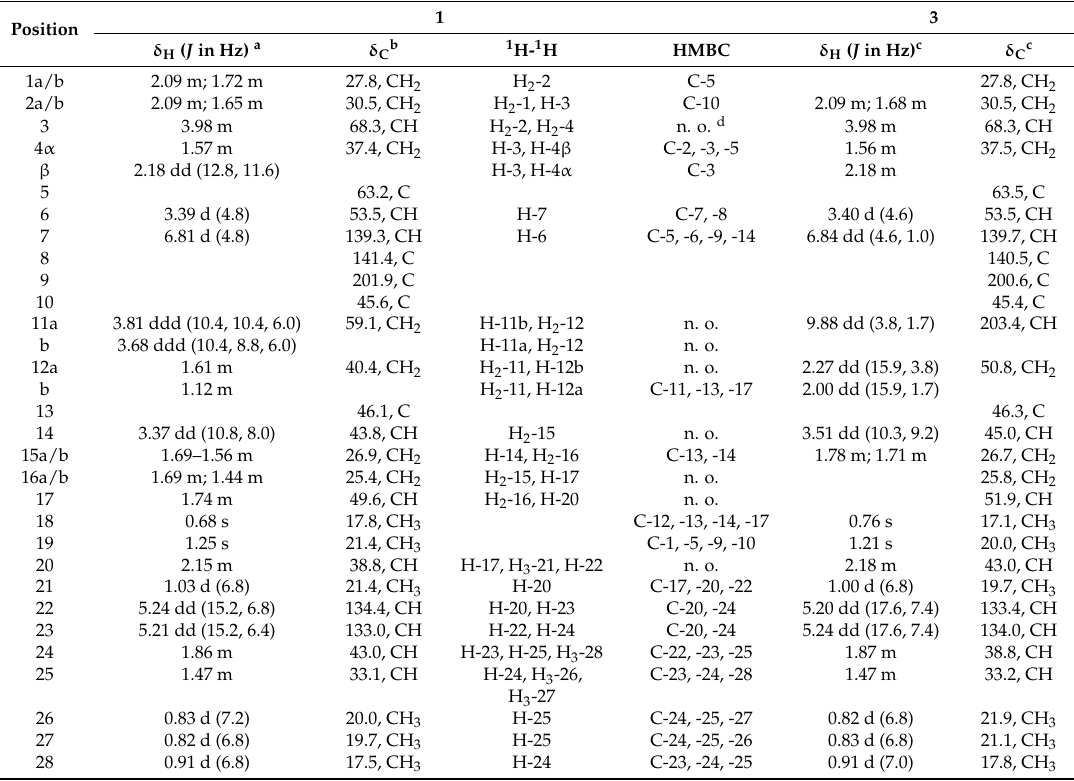
Table 1. 1 H- and 13 C-NMR data, 1 H- 1 H COSY, and HMBC correlations for secosterol 1 and the 1 H- and 13 C-NMR data for 3- O -deacetylluffasterol B ( 3 ).